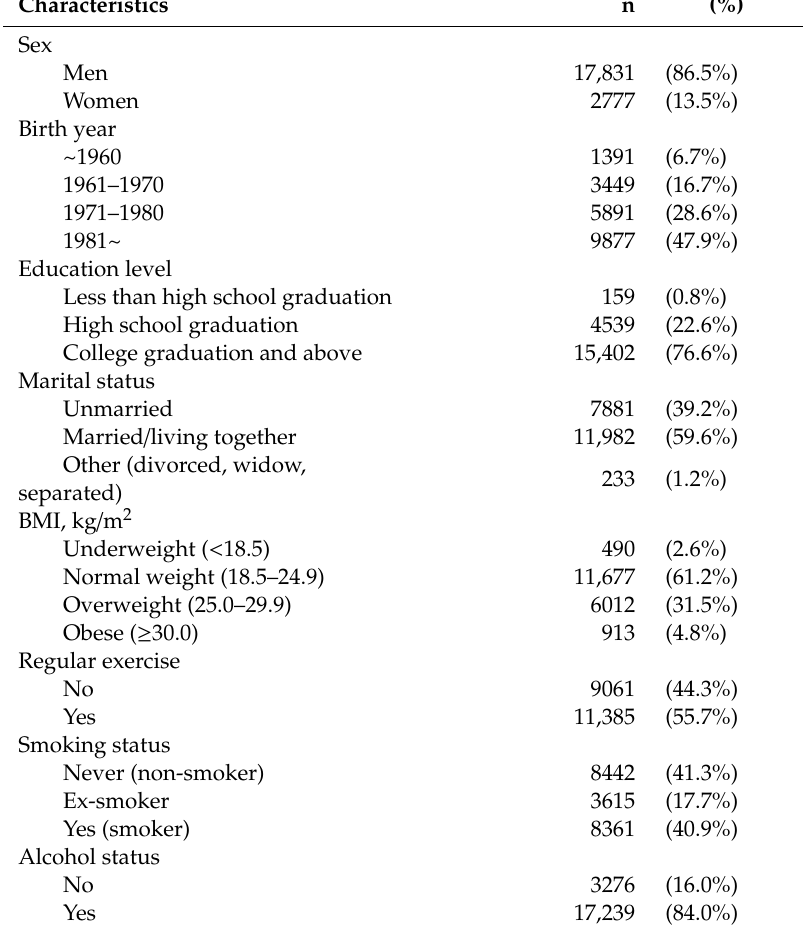
Table 1. Demographic characteristics of the cohort (N = 20,608).